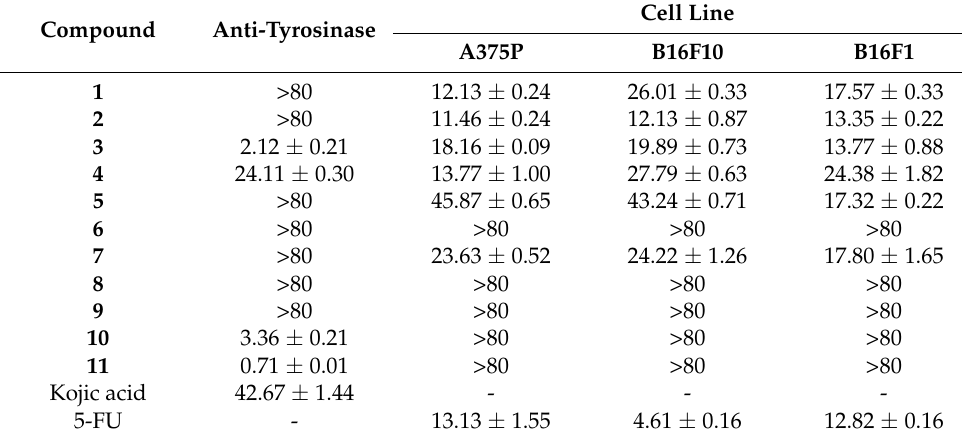
Table 1. Tyrosinase inhibitory and cytotoxic effects of compounds 1 – 12 (IC 50 , µ M).